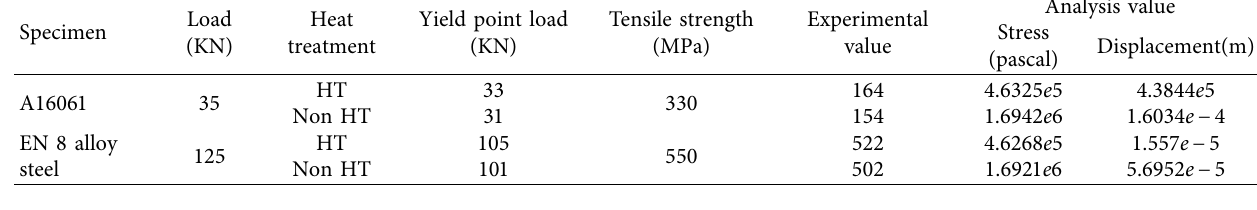
Table 3: Observations of tensile testing of an aluminum and steel specimen and predictions.